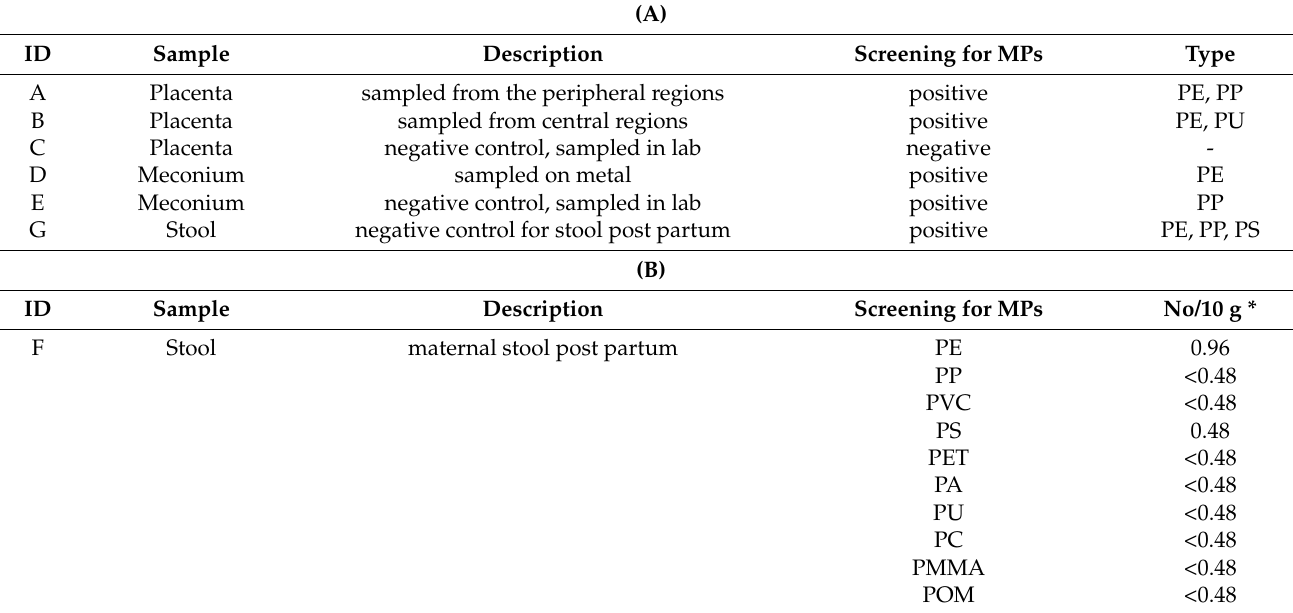
Table 1. ( A – C ): First phase screening for microplastic particles in ( A ) human placenta, ( A ) meconium, ( B ) maternal stool, and ( C ) contamination controls (0.05–0.5 mm). Negative controls include screening for MPs of sample preparation instruments and storage containers without the actual tissues (placenta, meconium, maternal stool). PE = polyethylene, PP = polypropylene, PVC = polyvinylchloride, PS = polystyrene, PET = polyethylene terephthalate, PA = polyamide, PU = polyurethane, PC = polycarbonate, PMMA = polymethylmethacrylate, POM = polyoxymethylene, EPDM = ethylene- propylene-diene rubber copolymer, NBR = acrylonitrile-butadiene rubber; * limit of quantification (LOQ) =